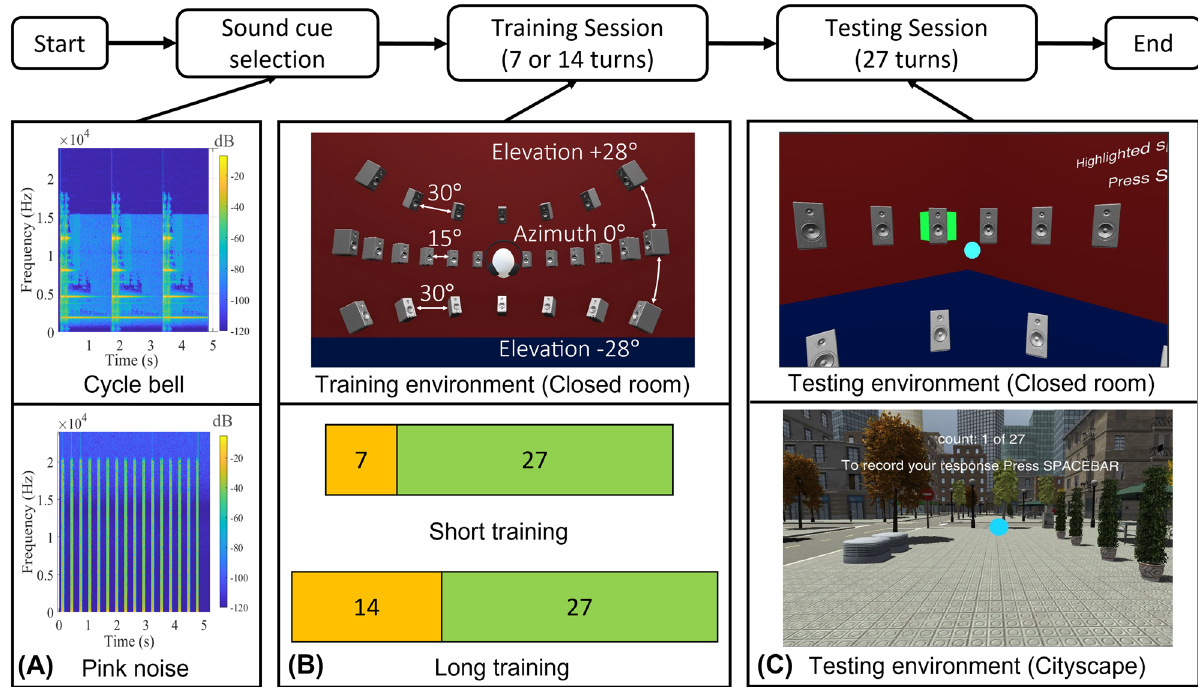
Figure 1. Illustration of the experimental design and detailed pipeline of the user study. At the top, the figure shows the workflow of the experiment. First, the user is randomly assigned a sound cue among two options: ‘Cycle bell’ and ‘Pink noise’. As shown in the spectrographs ( A ), Cycle bell (introduced by us, top of A) had tonal components below 1500 Hz, while Pink noise (the standard sound used in localisation experiments, bottom of A) was flat in frequency. Then, the user was brought into a ‘closed room’ for training purposes ( B ). The room (top of B) contained a total of 27 virtual sound sources: 13 visible sound sources in the azimuth ◦ ◦ plane (0 elevation) with an angular distance of 15 in each, and seven sound sources for each of the elevations ◦ ◦ ◦ of + 28 and − 28 . The angular distance between the sources at non-zero elevation was 30 . In the training room, we introduced two types of training (bottom of B): ‘short training’ with seven trials and ‘long training’ with fourteen trials. Finally, users were brought into a randomly selected testing environment ( C ) where they were asked to locate the source of 27 audio stimuli. We used two environments: a closed room (similar to the one used for training, with speakers well visible, top of C) and a cityscape environment (with no visual cues, the bottom of